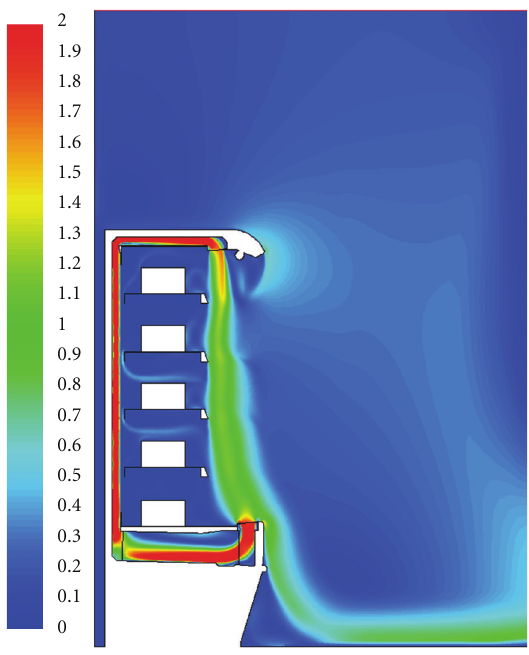
Figure 7: Velocity field numerical predictions for recirculated air curtain, v (ms − 1